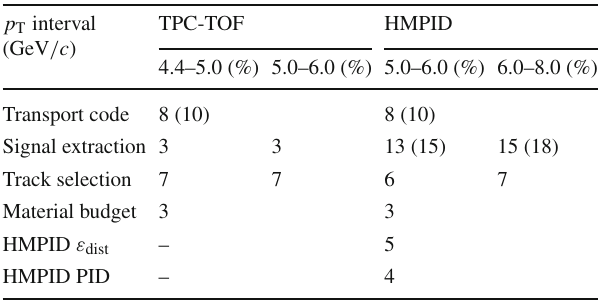
Table 1 Details of the systematic uncertainties assigned in the TPC and TOF combined and HMPID analyses. The values in the parentheses refer to the systematic for the anti-deuteron spectra when different to the deuteron ones p T interval (GeV / c )